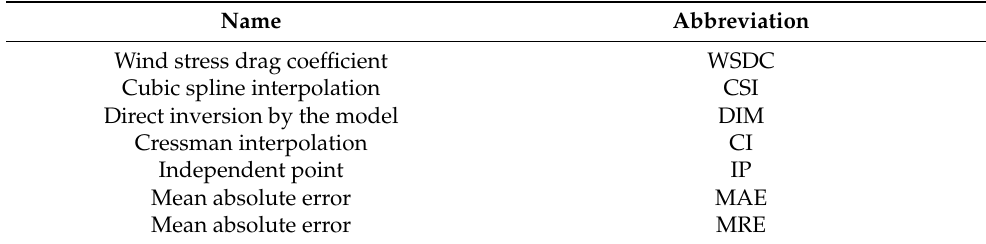
Table 3. A list of abbreviations and variables.